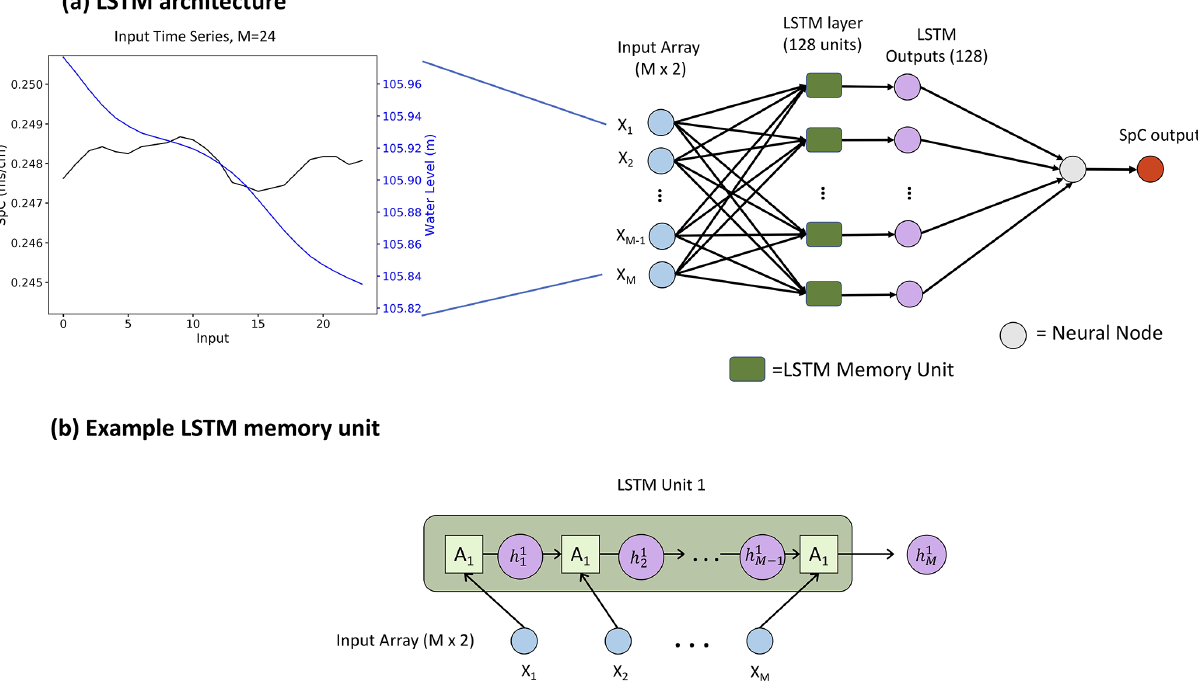
Figure 4. Illustration of LSTM models for gap filling. Panel (a) shows the architecture of the LSTM models, where M is the input window size; it includes example input with M = 24 and an example LSTM layer with 128 units. Panel (b) presents an example of an LSTM unit, where A is the repeating module of the LSTM unit, and h is the